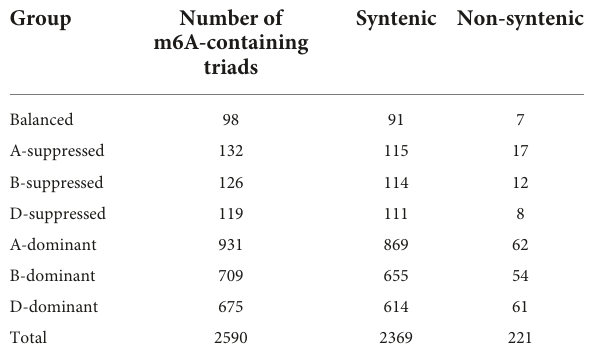
TABLE 1 Number of m6A-containing triads.